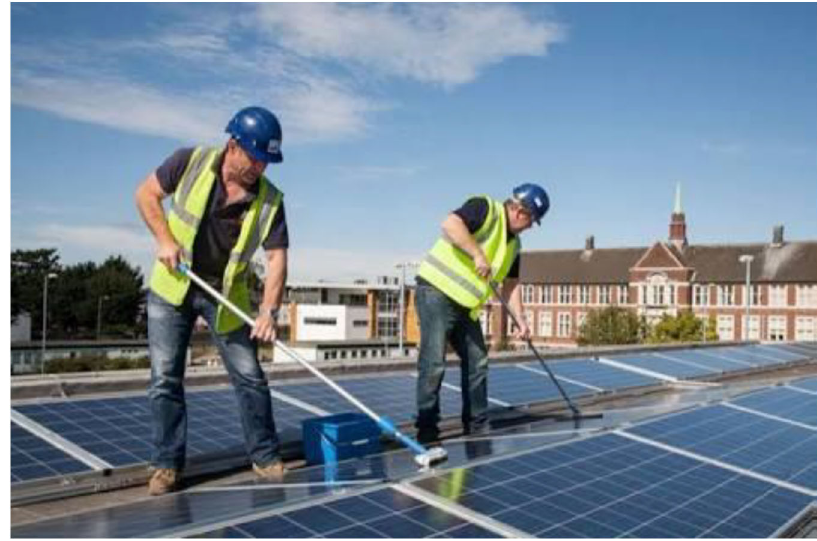
Figure 17. Manual cleaning [76].